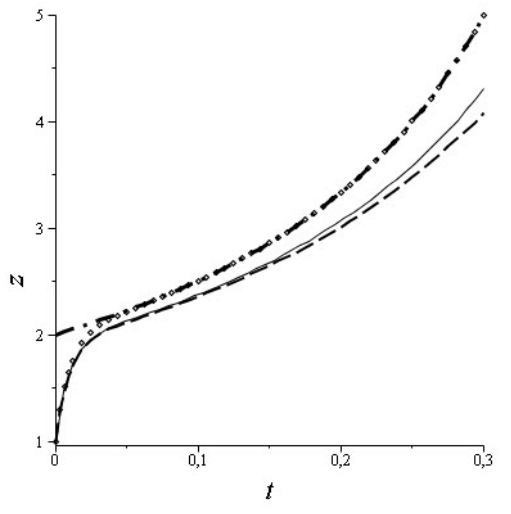
Figure 2. Trajectory z ( t , ε ) with ε = 0.01 and its